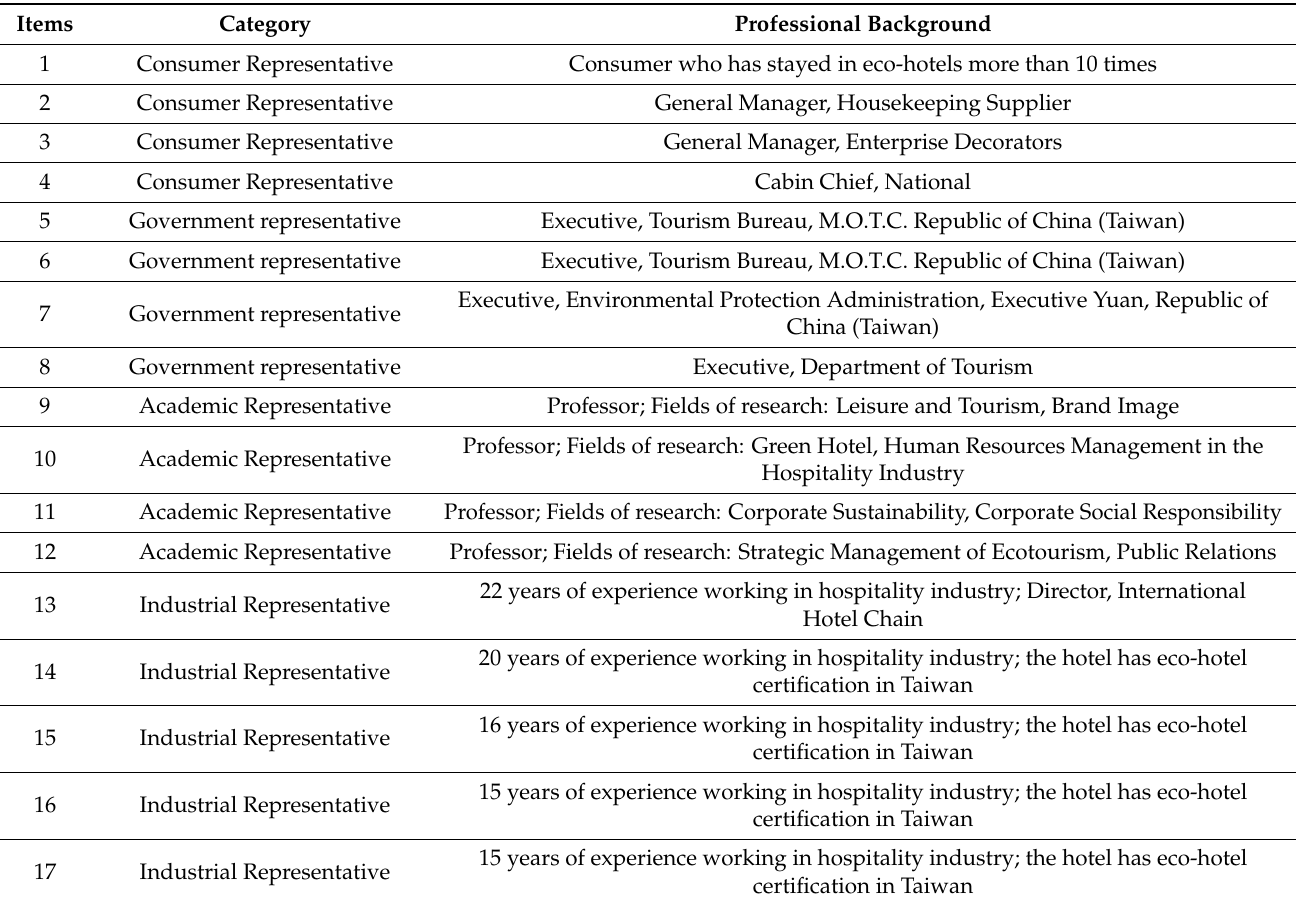
Table 2. Description of Participating Experts by the AHP